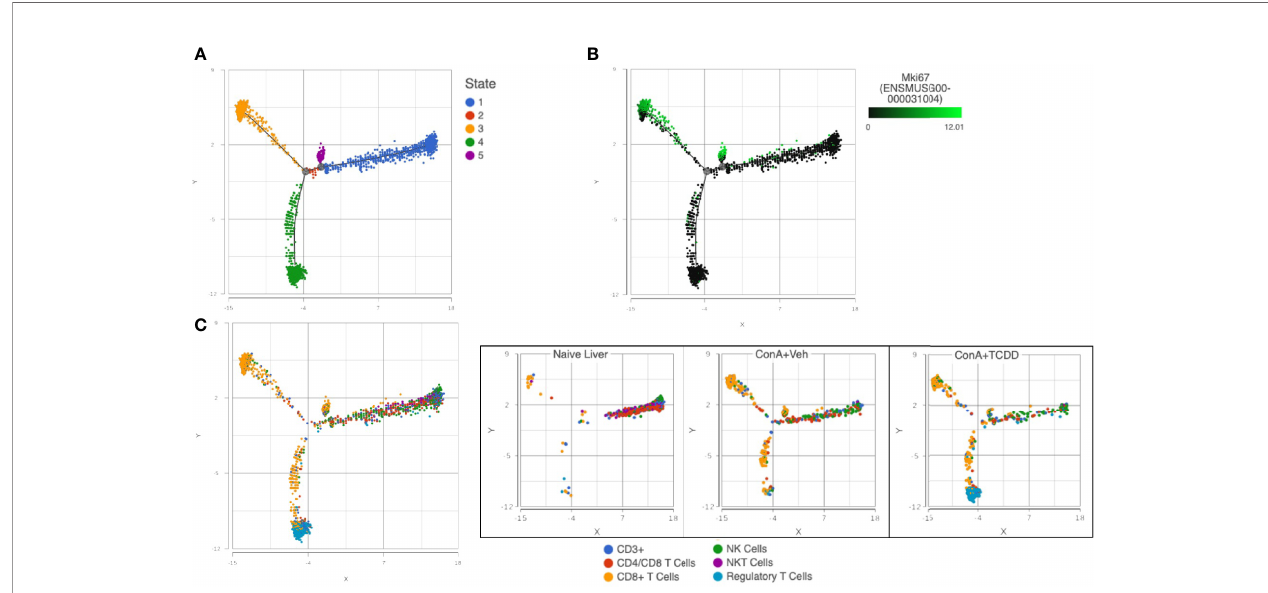
FIGURE 11 | Trajectory Analysis of NK and T cell subsets uncovers reduced proliferation of CD8+ T cells with TCDD treatment. C57/BL6 mice were injected with ConA followed by vehicle or TCDD 1 hour later as described in Figure 1 legend. Liver in fi ltrating cells were isolated and scRNA-seq was performed as described in Methods. Monocle 2 within Partek ® Flow ® software v10.0 was used for trajectory analysis. (A) Pseudotime plots determine 5 different states for T cells and NK cells. (B) States 3 and 5 were shown to contain the highest expression of Mki67 , a gene that encodes for KI-67, a marker of proliferation. (C) Colored by cluster, states 3 and 5 contained predominantly CD8+ T cells and TCDD was shown to decrease the amount of these actively proliferating